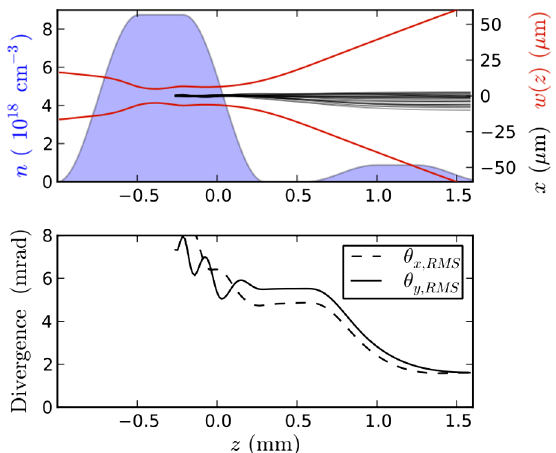
FIG. 3. Aspect of the wakefield in the second jet, during a PIC simulation with (left panel) and without (right panel) a second laser pulse. The electron density and the laser intensity are represented in blue and red respectively. The dark blue spot represents the electron